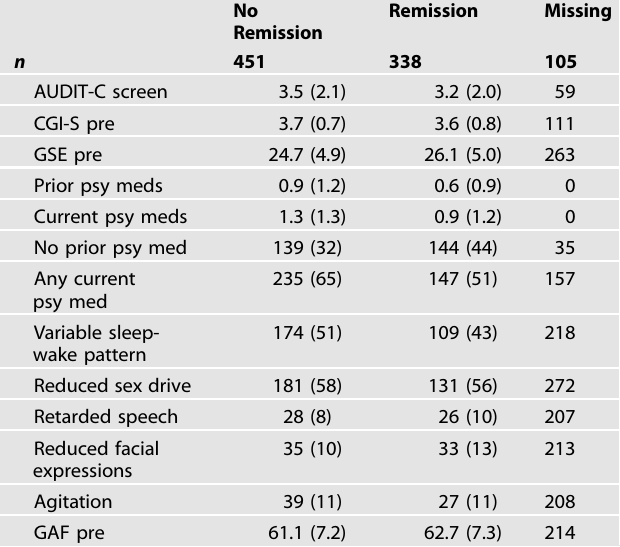
Table 1. Patient summary characteristics grouped by type